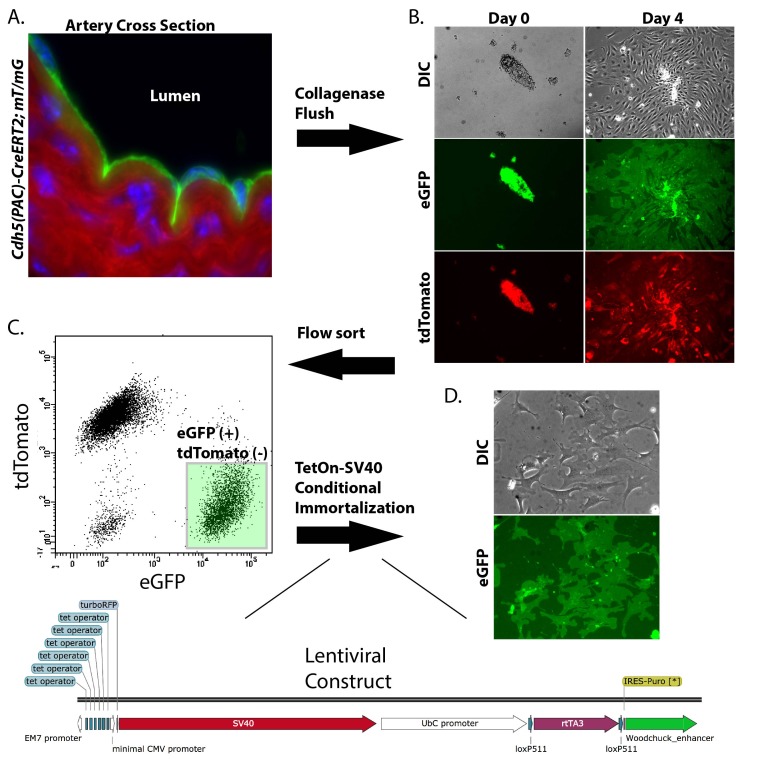
Isolation and conditional immortalization of aortic endothelial cells.Endothelial cells were marked by induction of the mT/mG reporter in Cdh5(PAC)-CreERT2; mT/mG mice (A), isolated by collagenase flush and cultured (B), sorted on the mT/mG markers (C) and then immortalized by TetOn-SV40T (D).